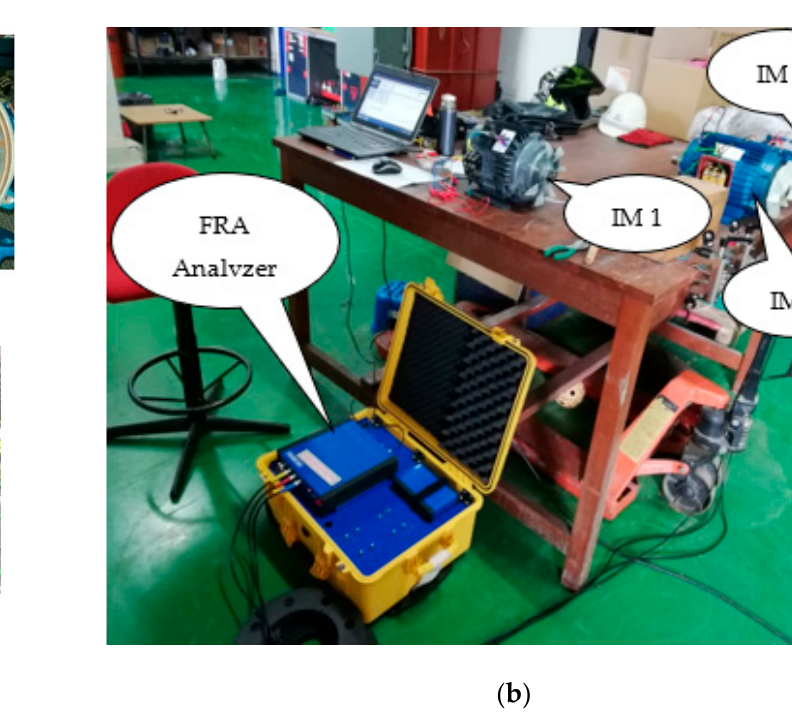
Figure 1. Measurement setup in the laboratory. ( a ) SC and OC faults development. ( b ) Measurement connections.